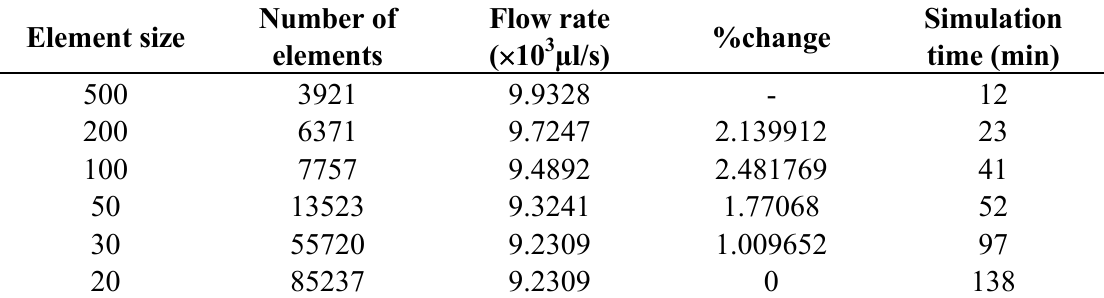
Table 1. Mesh sensitivity analysis for flow at diffuser direction (Diffuser angle = 5  ; AR =